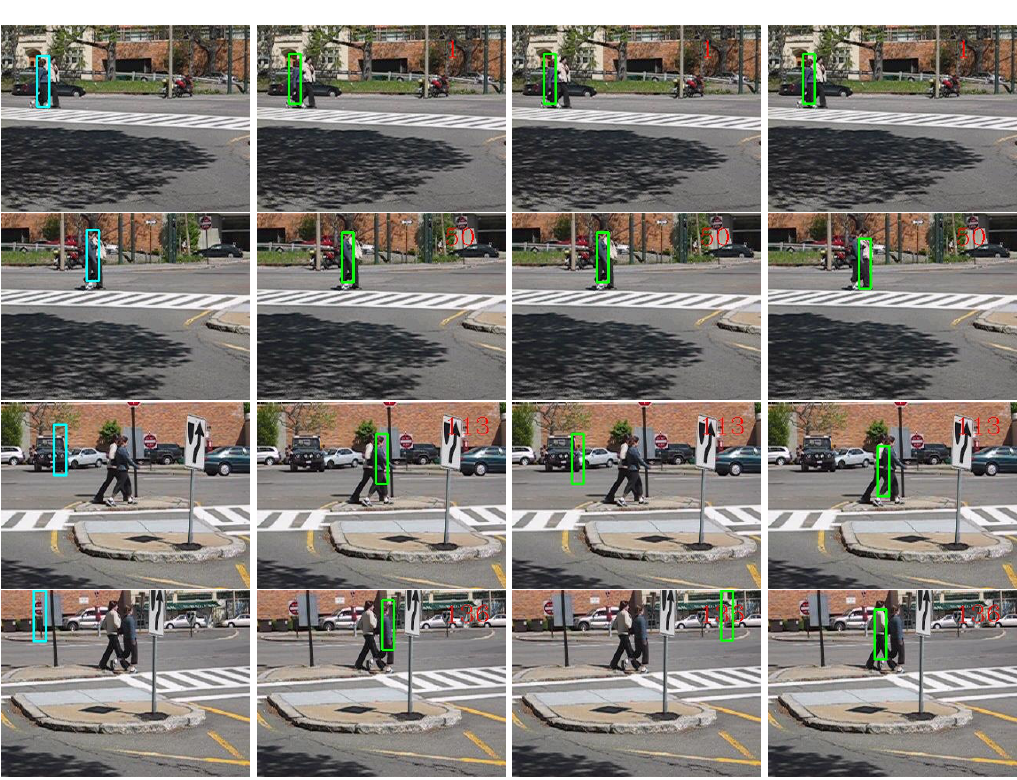
Figure 9. Tracking results on the “Pedestrian1” sequence using different update policies. Column 1: “MILTracker”. Column 2: “AdpCov+cu”. Column 3: “AdpCov+nu”. Column 4: “AdpCov+fu”. Row 1: Frame #1. Row 2: Frame #50. Row 3: Frame #113. Row 4: Frame